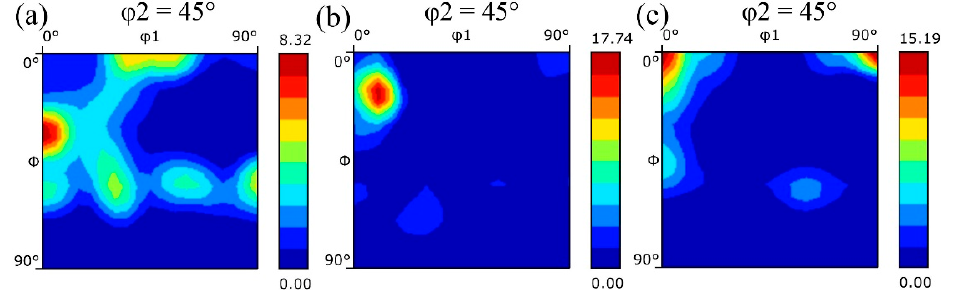
Figure 12. φ 2 = 45° ODF sections showing center textures ( a ) 800 °C—78%, ( b ) 750 °C—78%, ( c ) 700 Figure 12. ϕ 2 = 45 ◦ ODF sections showing center textures ( a ) 800 ◦ C—78%, ( b ) 750 ◦ C—78%, °C—78%. ( c ) 700 ◦